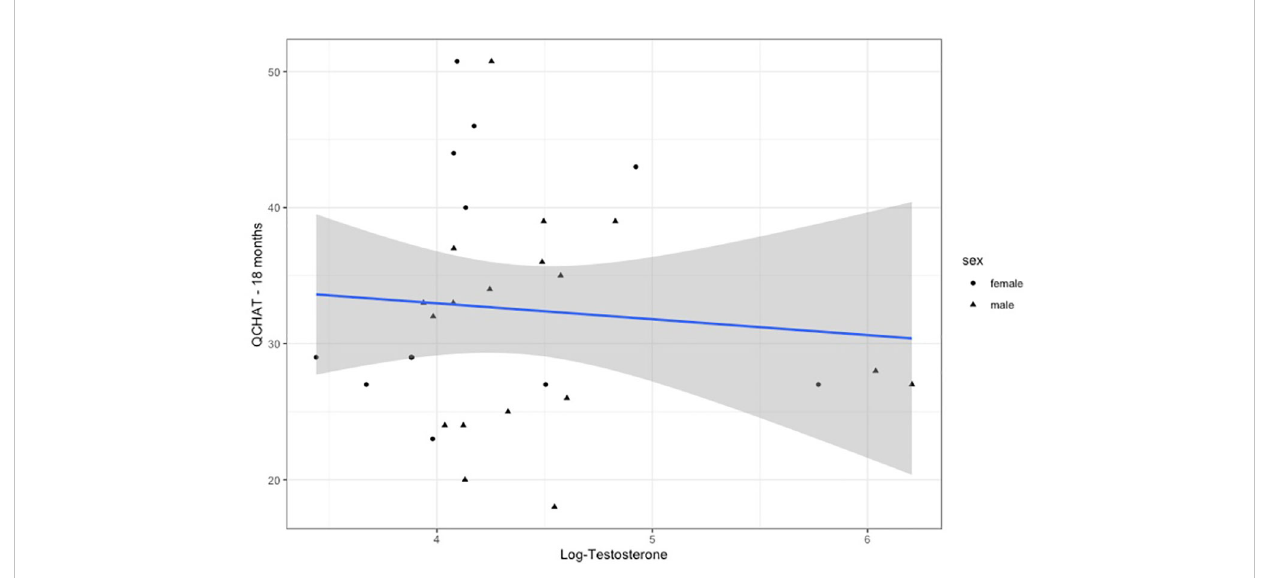
FIGURE 3 Testosterone levels (log-transformed) plotted for Q-CHAT scores. Linear regression fi t is for both males and